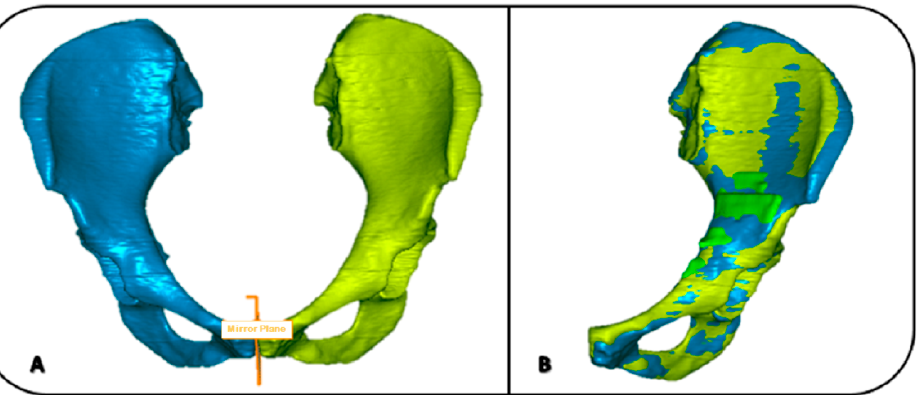
Figure 4. Bone models to depict the procedure for mirroring ( A ) and spatial matching of the two hemipelvis ( B ). In ( A ), the unaffected hemipelvis (in blue, on the left) is to be mirrored to the affected one (in yellow, on the right). This latter model, the affected one, is then matched ( B ) to the unaffected one (blue); the tumor in the affected hemipelvis (from the registration as in Figure 3) is depicted in green.